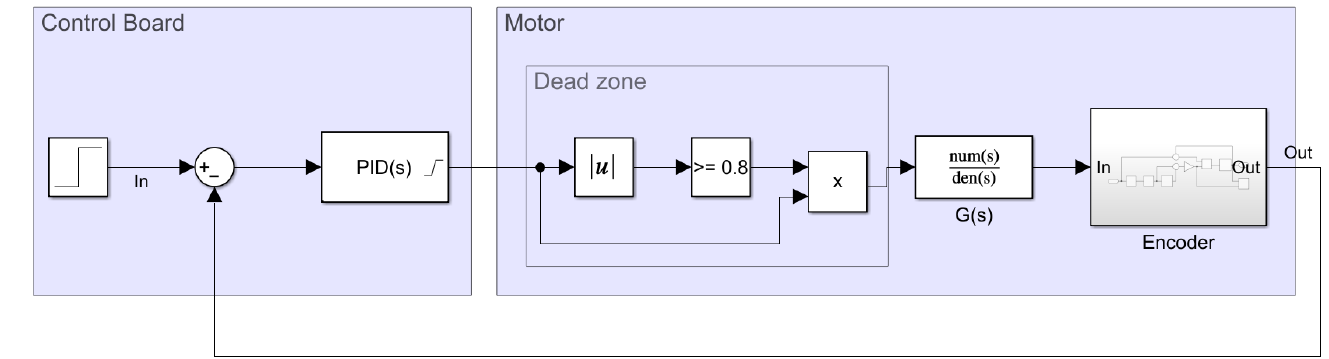
Figure 16. Simulink ® continuous control loop model used by the FRB PID tuner.